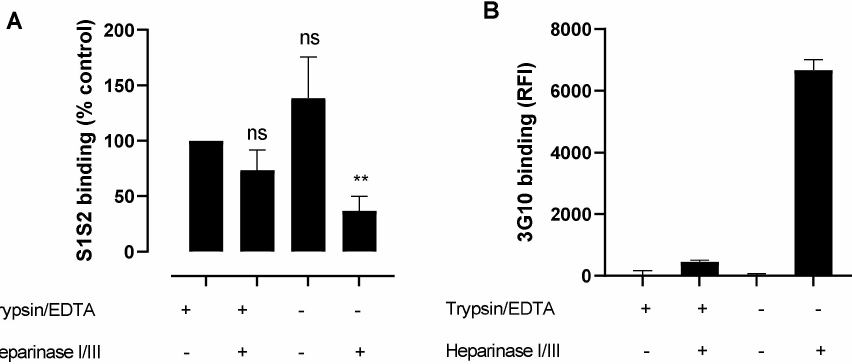
Figure 10. Removal of heparan sulphates only partly inhibits wtS1S2 binding. ( A ) RT4 cells were pretreated for 3 h with heparinase I/III mixture or control growth medium and then harvested by either trypsin/EDTA (+) or non-enzymatic cell dissociation solution ( − ) and then incubated with 100 nM wtS1S2 at 37 ◦ C before staining with anti-His6 secondary antibody labelled with Dylight 488. The data are shown relative to the non-trypsinised- and non-heparinase-treated control and are the means ± SEM from 3–4 independent experiments performed in duplicate. Significance of difference from the control was assessed by a one-sample t test. ns = not significant; ** p < 0.001. ( B ) The effects of heparinase treatment was measured using antibody 3G10 that recognises the cleaved stubs of heparan sulphates. RT4 cells were pre-treated for 3 h with heparinase I/III mixture or control growth medium and then harvested by either trypsin/EDTA or non-enzymatic cell dissociation solution and then incubated with 3G10. Bound antibody was detected by an FITC-labelled secondary and cell-associated fluorescence was measured by flow cytometry. Data are the means ± SD from 2 separate experiments performed in